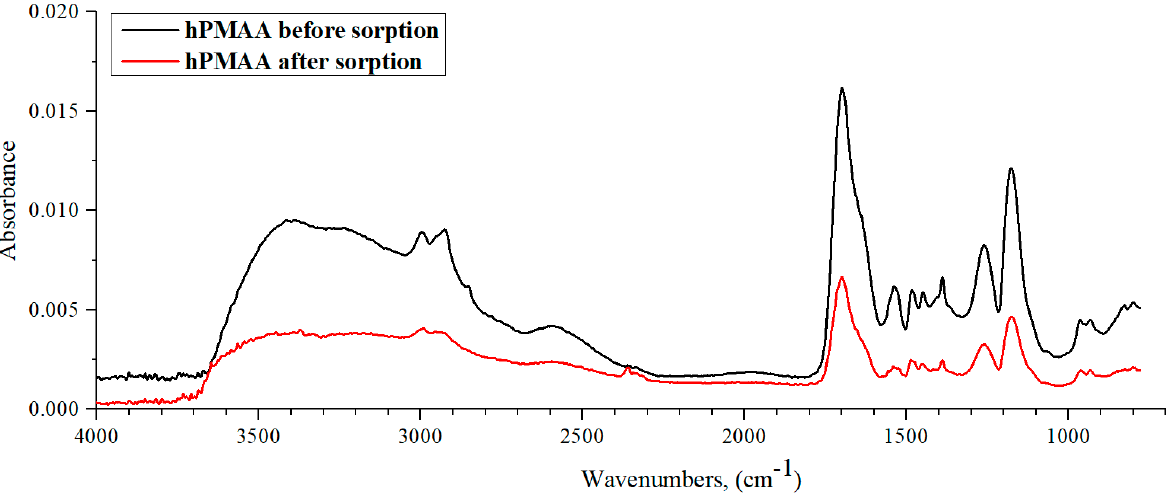
Figure 10. IR spectra of hPMAA before and after lanthanum sorption by interpolymer system 17%hPMAA-83%hP4VP. IR spectra of hP4VP before and after lanthanum sorption by the studied 17%hPMAA-83%hP4VP.